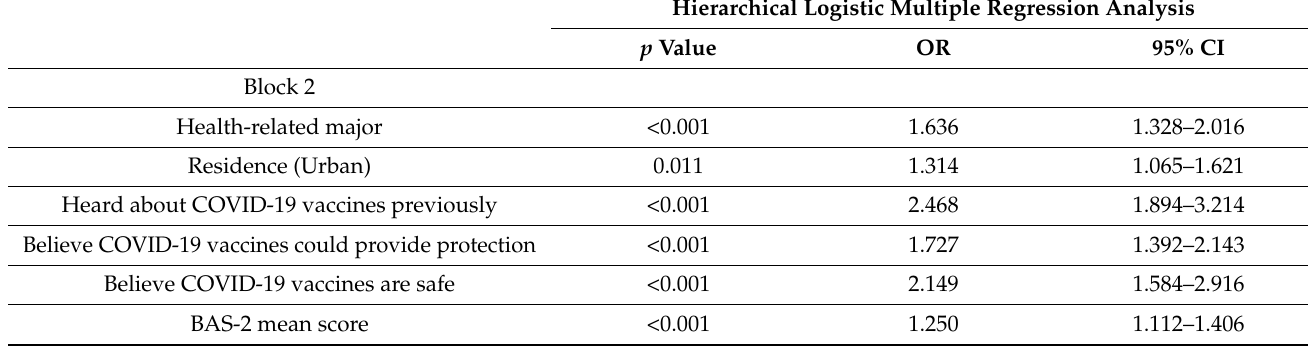
Table 2. Cont. Hierarchical Logistic Multiple Regression